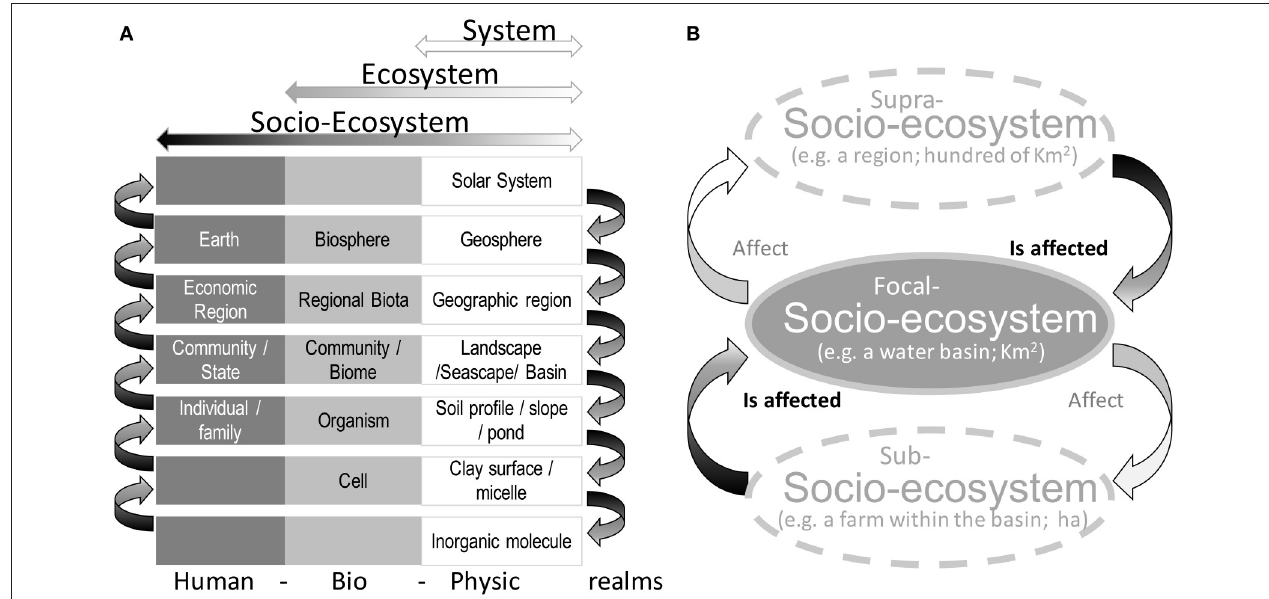
FIGURE 1 | (A) Nested and hierarchical character of socio-ecosystems (SES), with management that always requires a detailed analysis of (B) the factors “affecting” and “being affected” by the supra- and